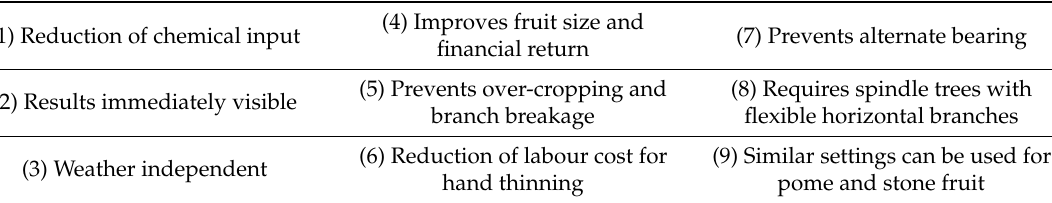
Table 2. Features of mechanical